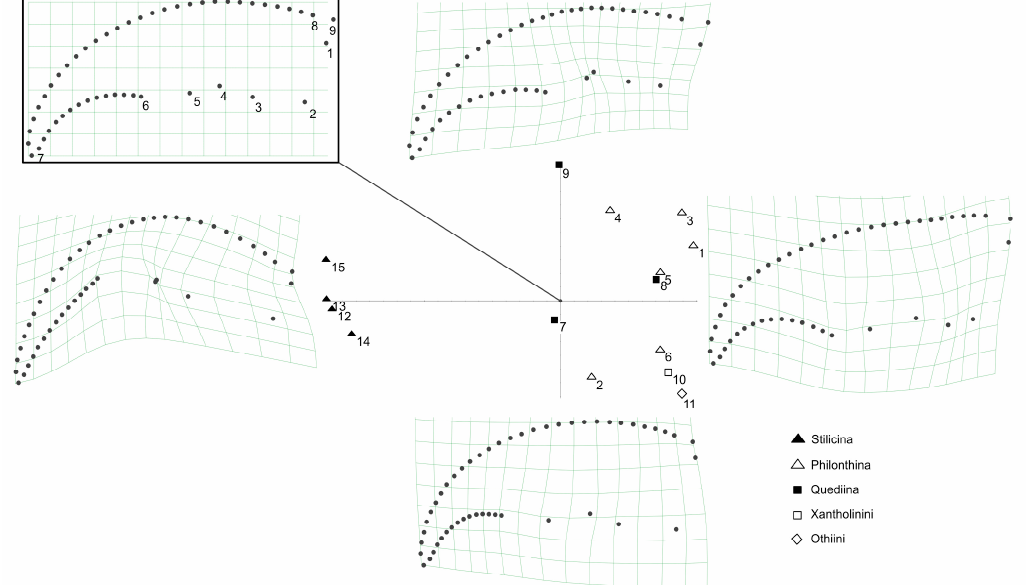
Figure 14. Principal component analysis of nine landmarks and 45 semilandmarks for 15 species. Species sorted by (sub-)tribe (see legend). PC1 along the x -axis, PC2 along the y -axis. For species numbers, see Table 1. Warped mandibles are depicted at the end of each PC, reference mandible (numbers correspond to landmarks in Figure 1) depicted at top left corner.